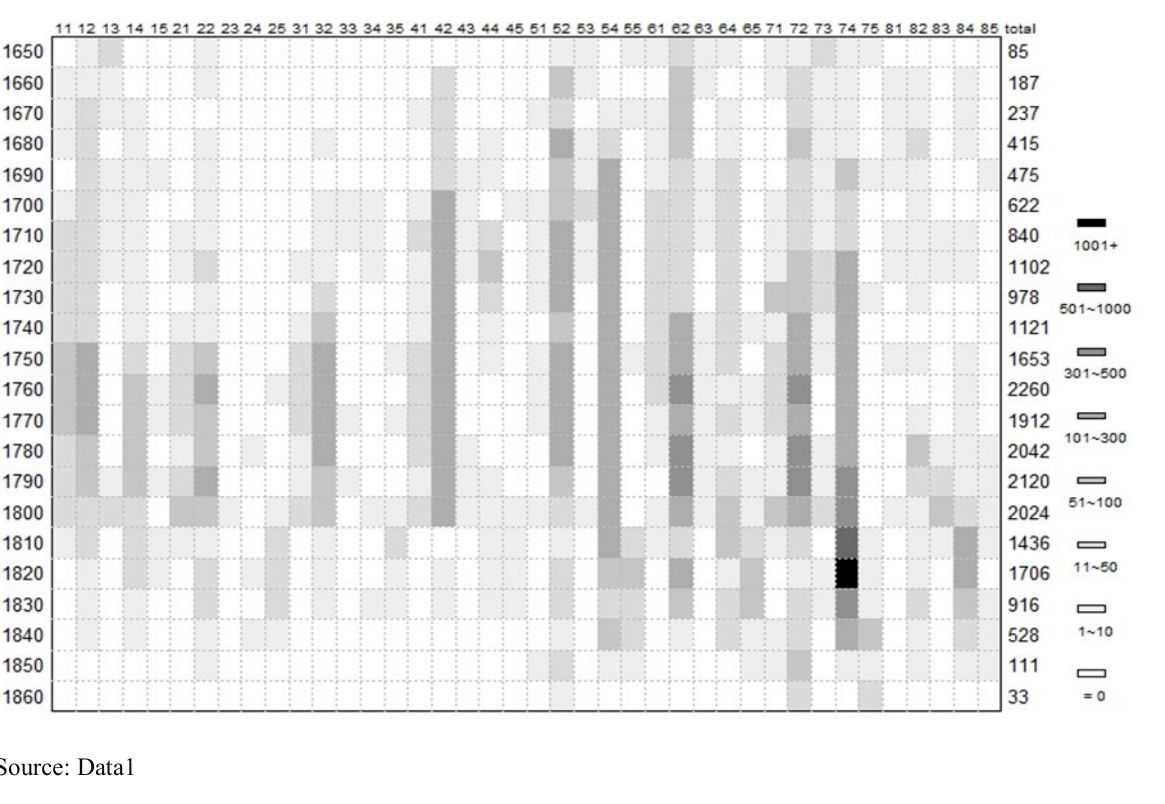
Figure 2. Voyages by route and decade (for 33,345 voyages, after regional imputation).